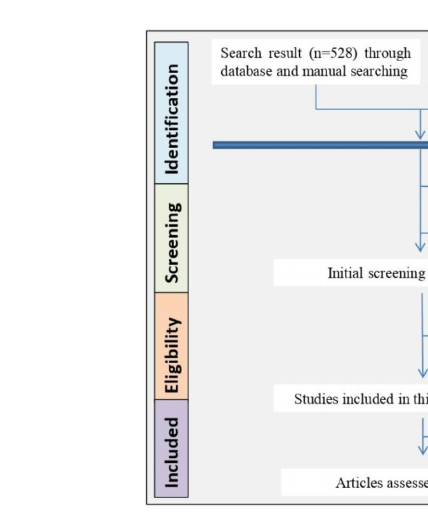
FIGURE 1 Flowchart showing screening methodology for the